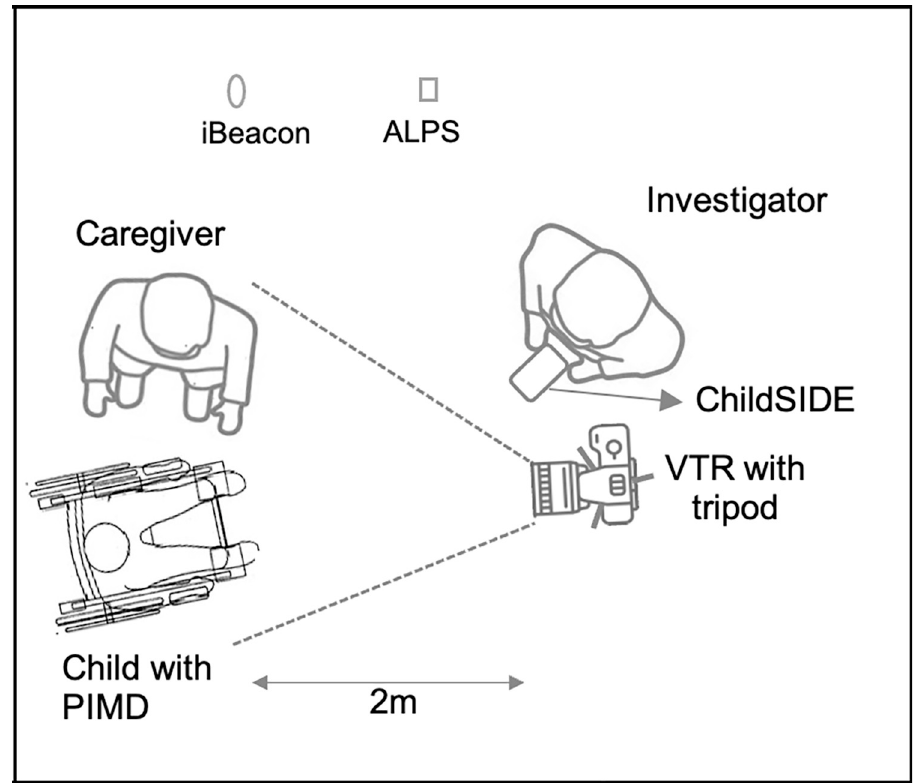
Fig 1. Experimental set-up showing the location and weather sensors and the videotape recorder (VTR) placed 2 meters from child with PIMD/IDs and caregiver.